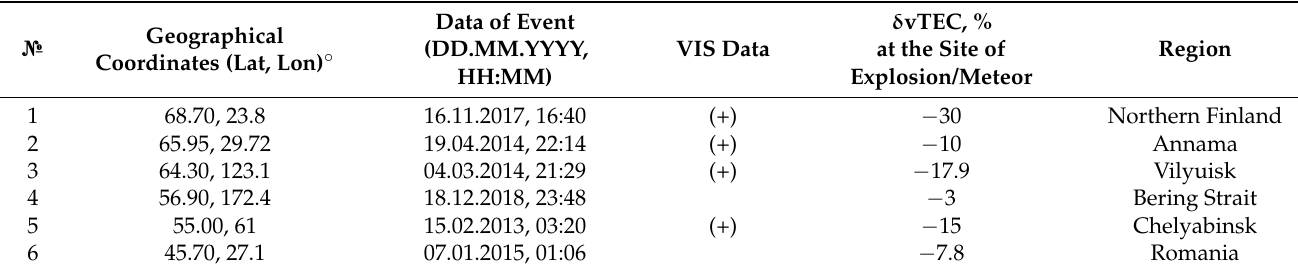
Table 1. Recent meteoroid